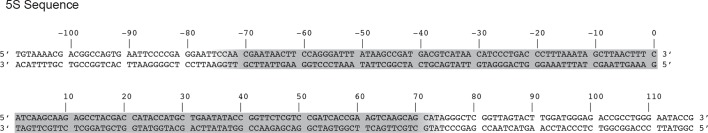
Sequence and dominant centered location of 5S nucleosomes.The approximated dyad of the dominant species, named N0, is considered to be 0. The DNA wrapped around the histone core is highlighted in gray. Since site-specific crosslinking used here only reports on internal histone-DNA contacts, the ambiguity of where the DNA wrapping begins is shown by the fading gray highlight.